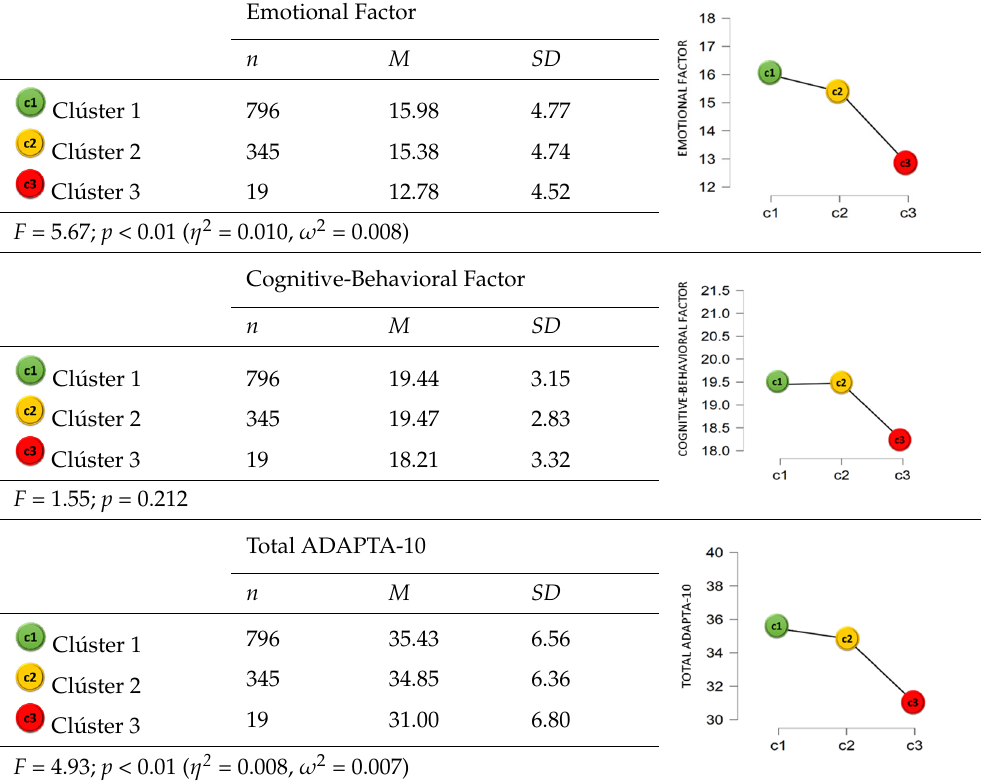
Table 1. Adaptation to change by a COVID-19 cluster, descriptive statistics, and ANOVA.